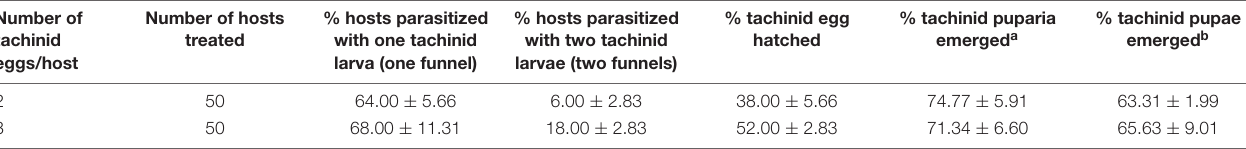
TABLE 1 | Survival of Exorista japonica on the fifth instar Bombyx mori . Number of tachinid